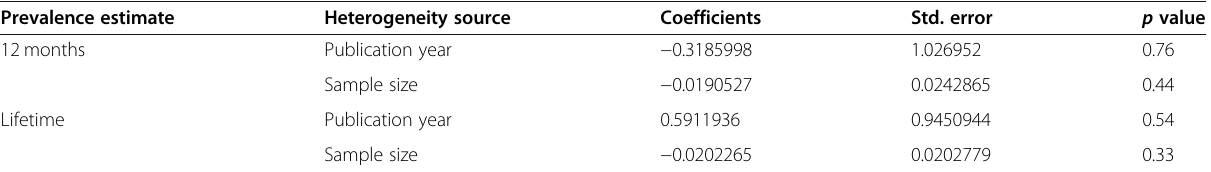
Table 3 A meta-regression analysis of factors for heterogeneity of the prevalence of blood and body fluid exposure among the